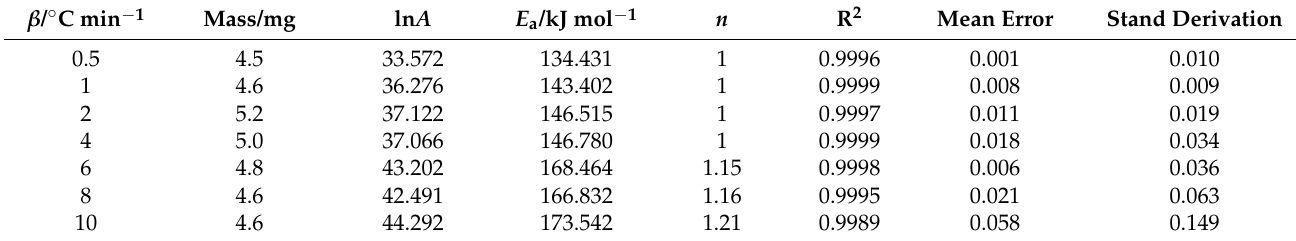
Figure 10. B/D method (ASTM E2041) plots ( a ) Arrhenius plots; ( b ) simulation curves by n th order kinetic parameters. Table 4. Kinetic parameters of B/D method simulation result of BTBPC.